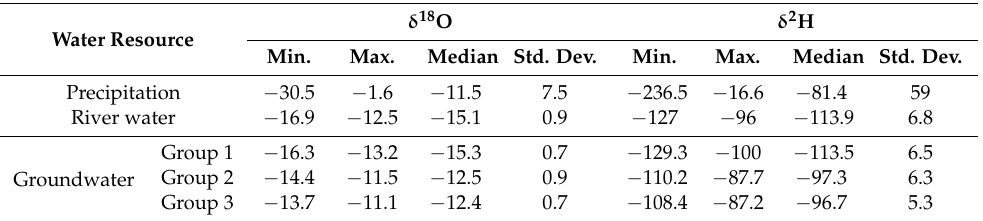
Table 3. δ 2 H and δ 18 O values of the water resources (unit: ‰